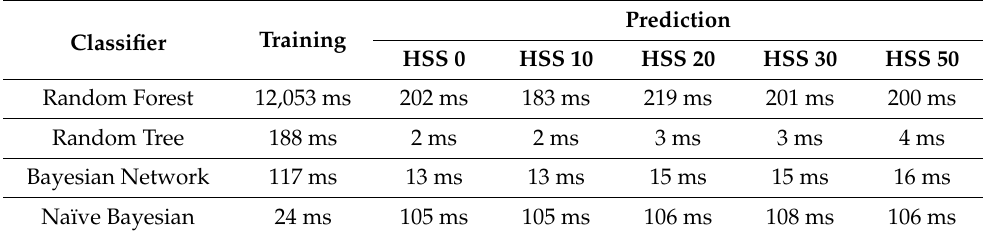
Table 10. Time consumption for classification training and